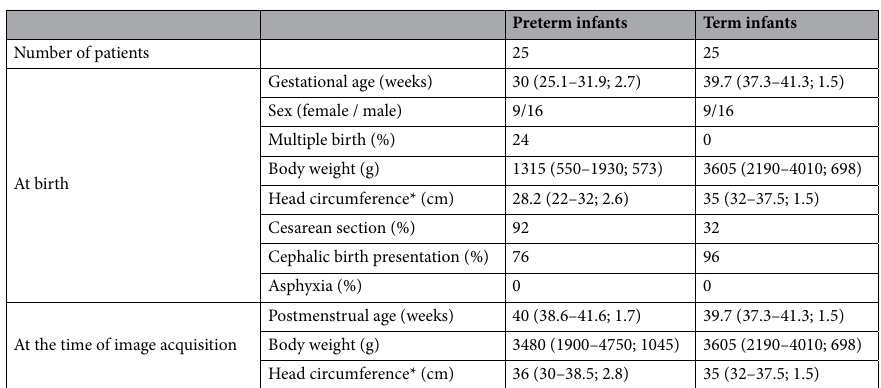
Table 2. Clinical characteristics of the study sample. *Manually measured; numerical data are displayed as median (minimum–maximum; interquartile range).